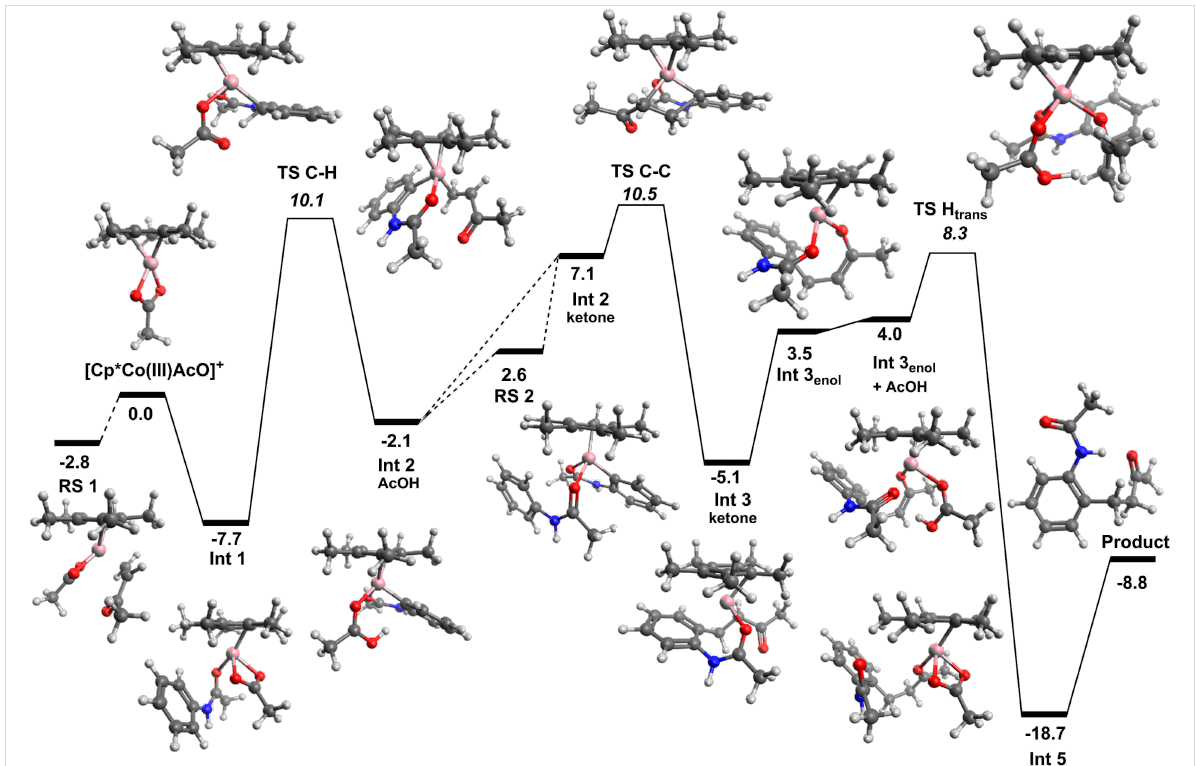
Figure 1: Mechanistic pathway for Cp*Co(III)-catalysed alkylation of acetanilide with 3-buten-2-one obtained from DFT studies; Int A is the direct interaction between the cationic [Cp*Co(III)AcO] + species and the 3-buten-2-one coupling partner.